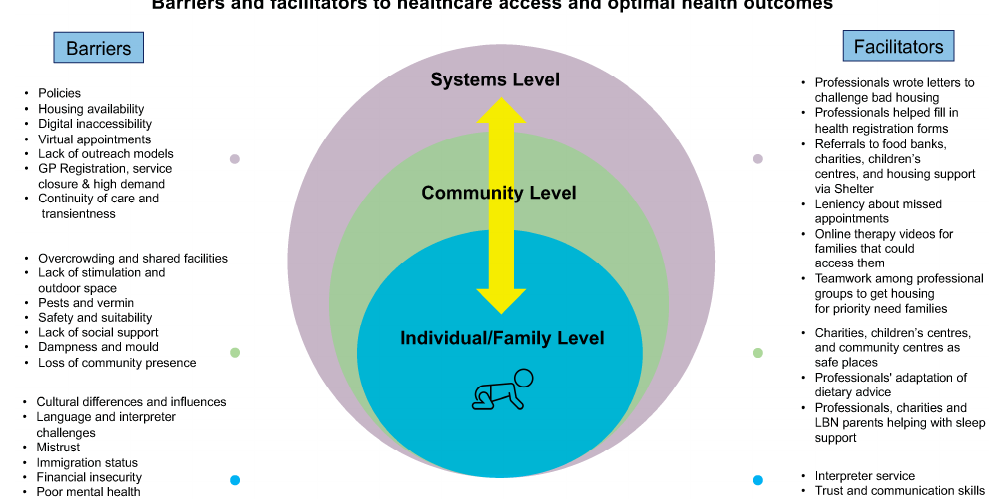
Figure 1. Barriers and facilitators to healthcare access and optimal health